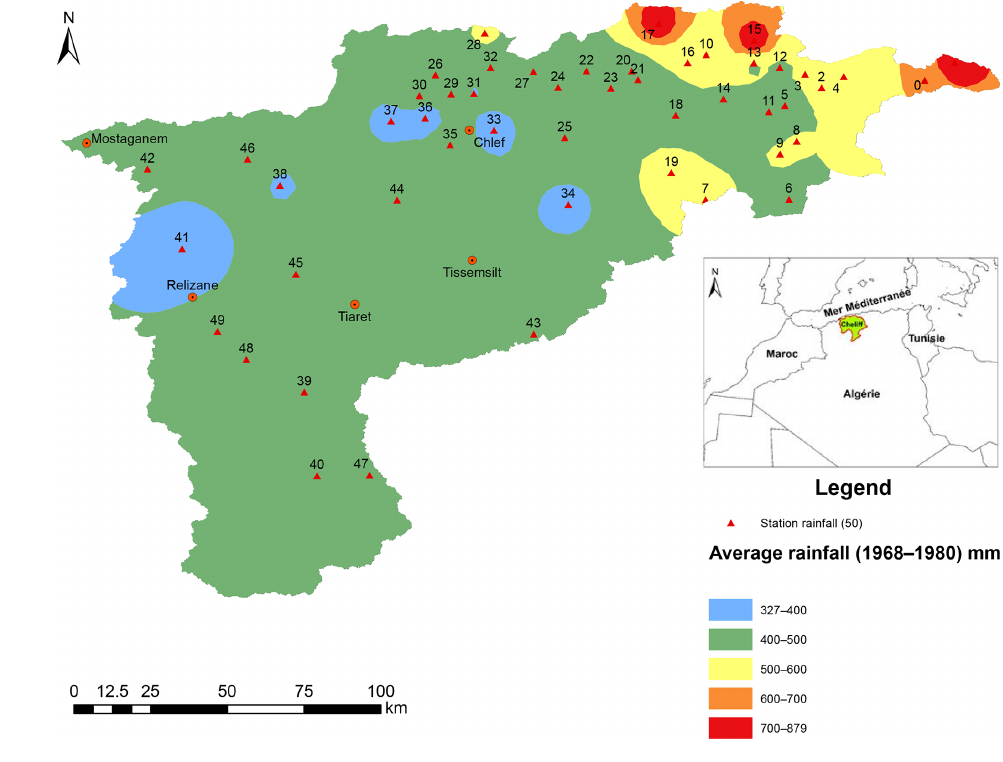
Figure 5. Inter-annual rainfall map in the Cheliff Basin (1968–1980).